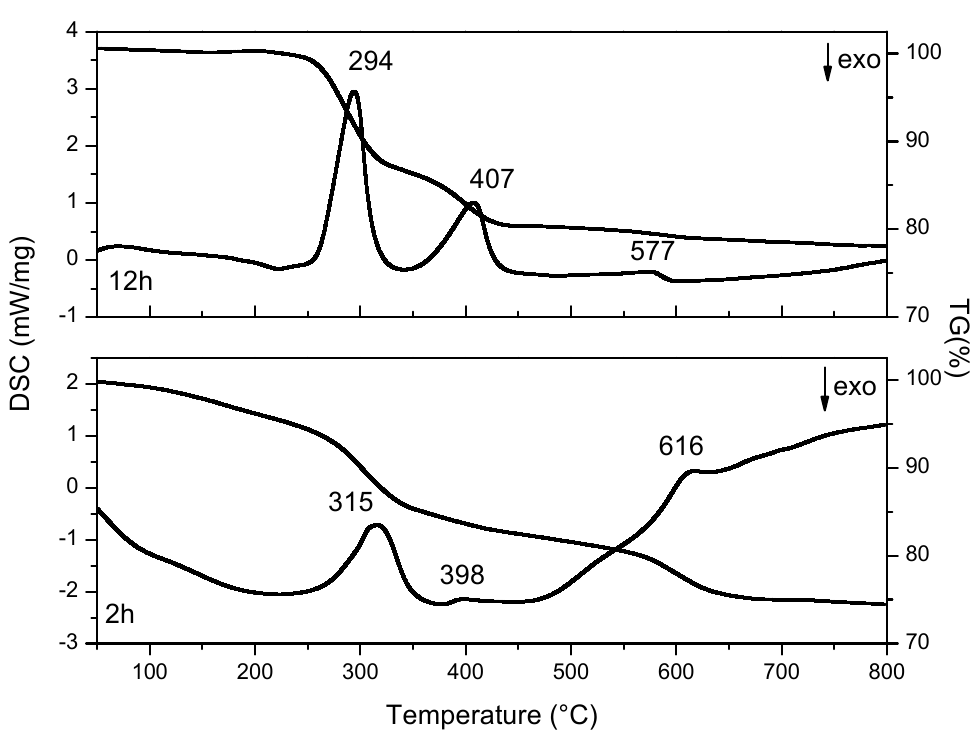
Figure 9 DSC and TG curves of Y(OH) 3 obtained at 2 and 12 h.